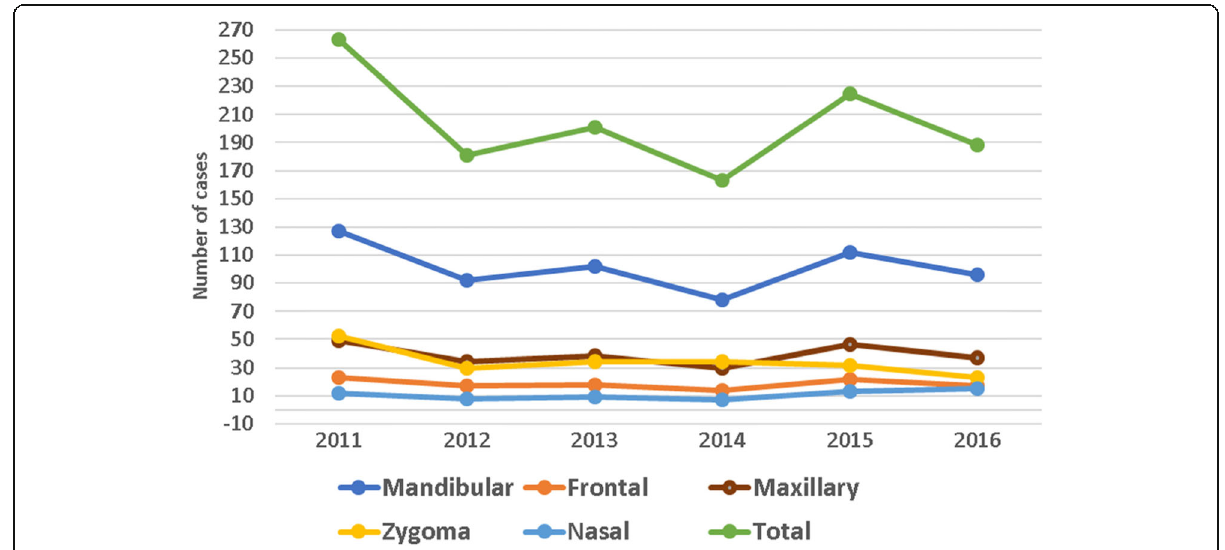
Fig. 5 Trend of different patterns of craniomaxillofacial fractures from the year 2011 to